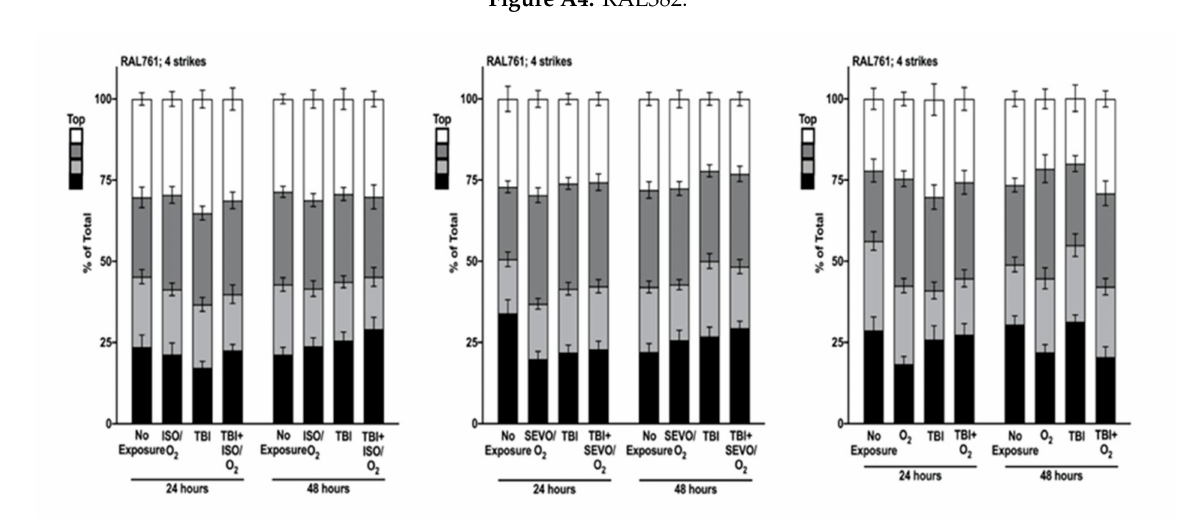
Figure A4. RAL382.